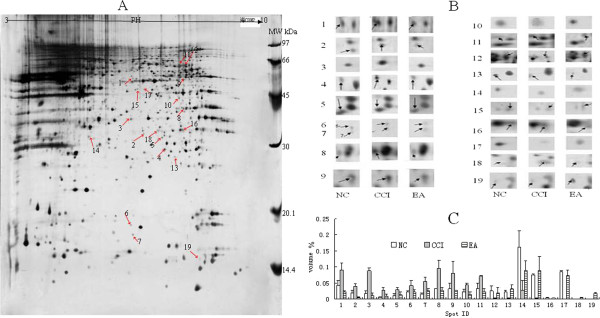
Expression profiles of the 19 identified differential proteins.(A) Differential expression profiles of the 19 identified differential protein spots (arrowheads) from pH 3–10 in 2-DE gel templates. (B) The excised protein spots from the regions of interest in A. Arrowheads represent protein spots that showed significantly different changes. Spot numbers are consistent with those shown in Table
1. (C). Histograms of the 19 differential proteins in the three groups. Data are presented as mean ± SD (n = 10 per group).